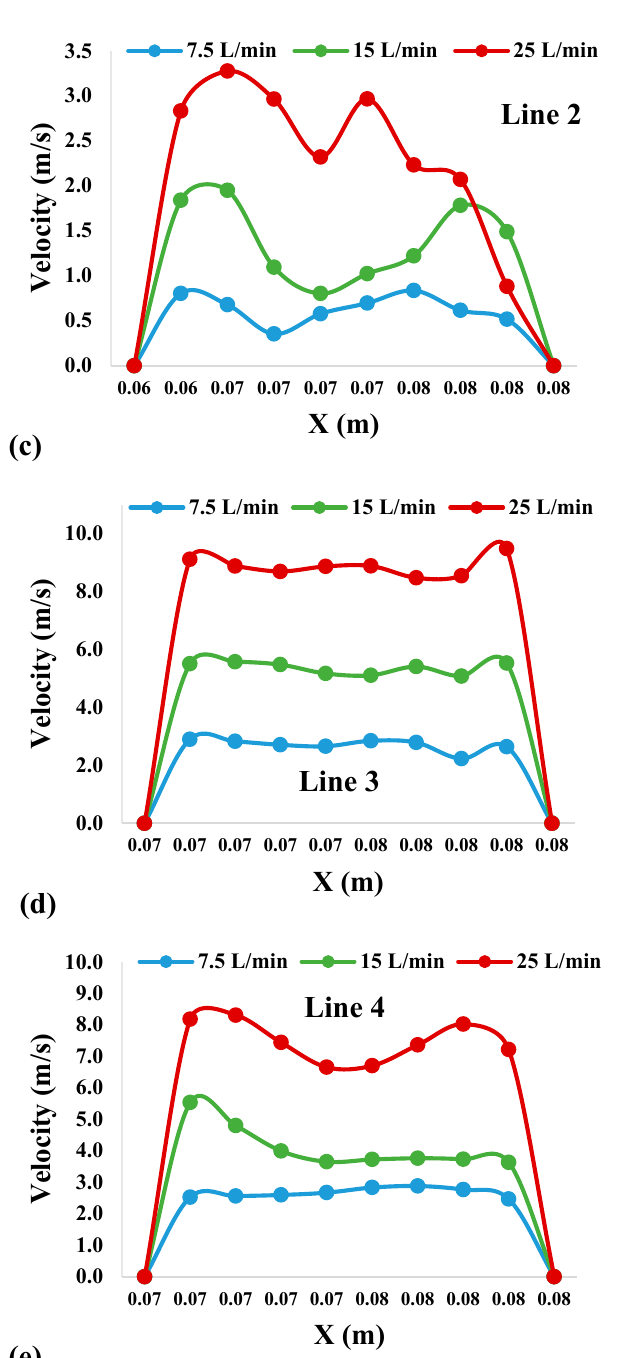
Figure 4. Velocity profiles for the three airflow rates at four selected cross-sections of the mouth-throat and trachea: ( a ) locations of cross-sections of the oral airways; ( b ) Line 1 at mouth area; ( c ) Line 2 at throat area; ( d ) Line 3 at trachea with 75% stenosis section; and ( e ) Line 4 at trachea with 50% stenosis section.